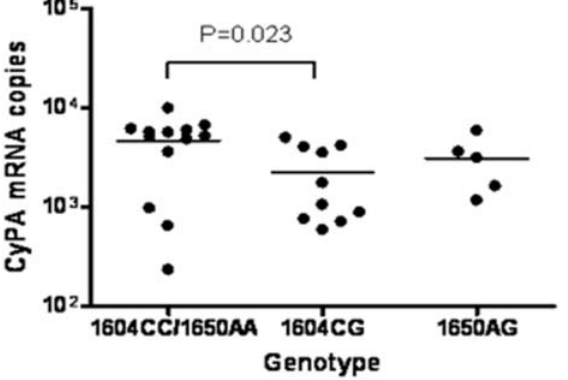
Figure 2. Analysis of CypA expression levels. CypA mRNA levels in PBMC obtained from healthy controls that were homozygous for the 1604 and 1650 major alleles (1604CC/1650AA), heterozygous for the 1604 minor allele (1604CG), or heterozygous for the 1650 minor allele (1650AG). CypA mRNA levels were normalized for b -actin mRNA levels.